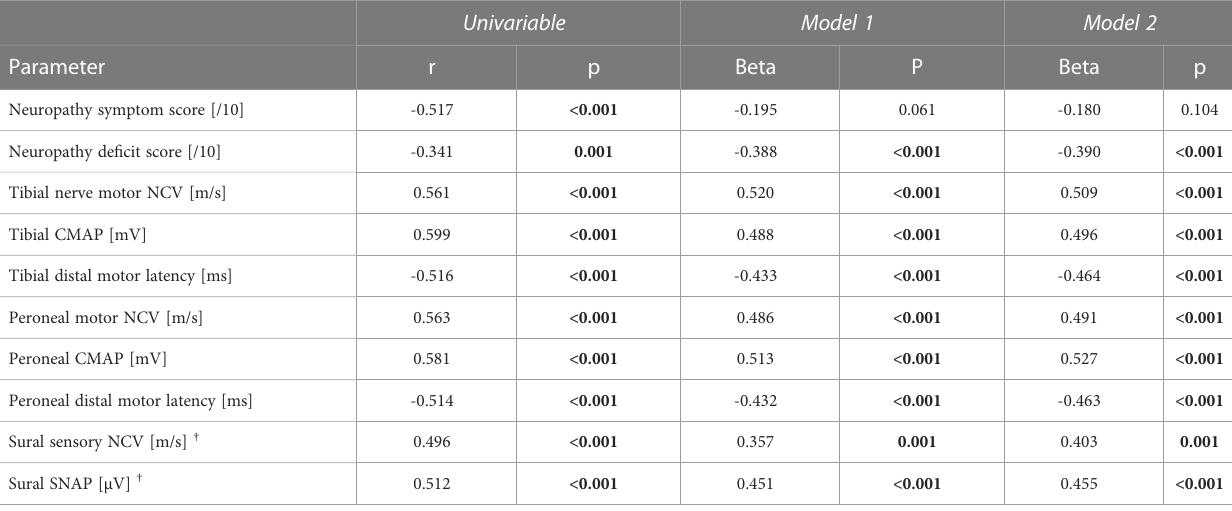
TABLE 2 Correlations of sciatic nerve´s FA (dependent variable) with appropriate clinical parameters and nerve conduction studies of the lower limb participants (independent variables) for all study